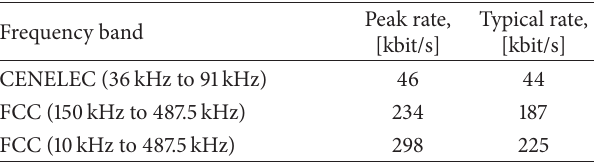
Table 4: G3-PLC data rates, based on